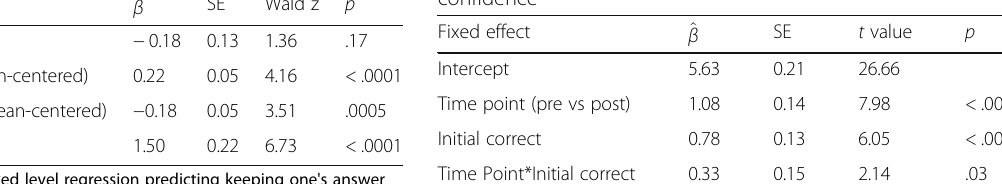
Table 6 Mixed-level regression analysis of predicting